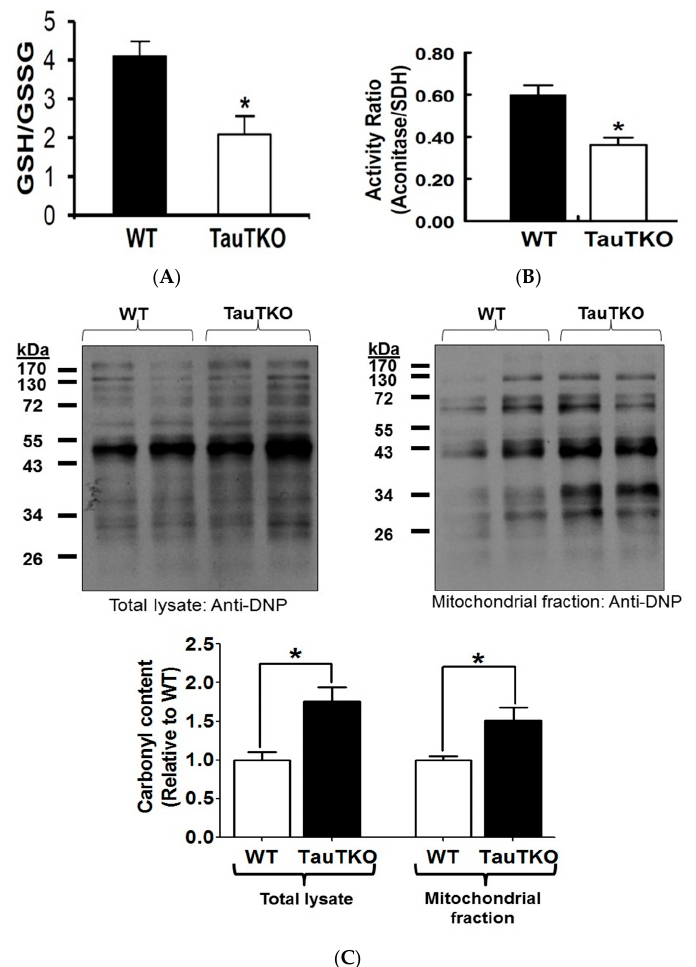
Figure 4. Taurine depletion causes oxidative stress. ( A ) Reduced (GSH) and oxidized (GSSG) glutathione content were determined and the data expressed as the glutathione redox state (GSH/GSSG), with values shown representing means ± SEM of 6–8 hearts. * p < 0.05; ( B ) Aconitase activity of WT and TauTKO mitochondria were assayed and normalized relative to SD activity. Values represent means ± SEM of 4–6 hearts. * p < 0.05; ( C ) Following preparation of total heart lysates and the mitochondrial fraction, proteins were derivatized with 2,4-dinitrophenylhydrazine and then subjected to western blot analysis of carbonylated proteins. The top panels show representative gels of carbonylated proteins of total lysate and the mitochondrial fraction. Values shown in the bottom panel represent means ± SEM for relative cellular and mitochondrial carbonylated protein content from 4–5 hearts. Values are expressed relative to WT, where WT is fixed at 1.0. * p < 0.05.